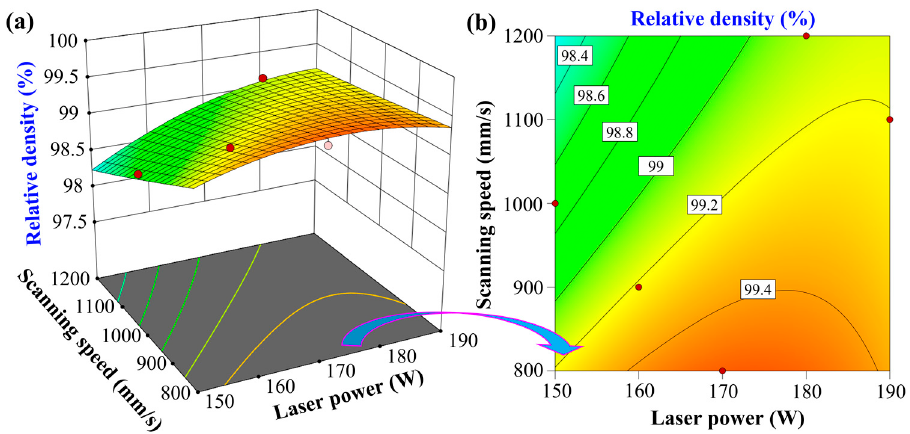
Figure 7. Response surface graph ( a ) and contour plot ( b ) of the effects of laser power and scan- speed on the relative density at scanning interval of 0.08 mm. ning speed on the relative density at scanning interval of 0.08 mm.